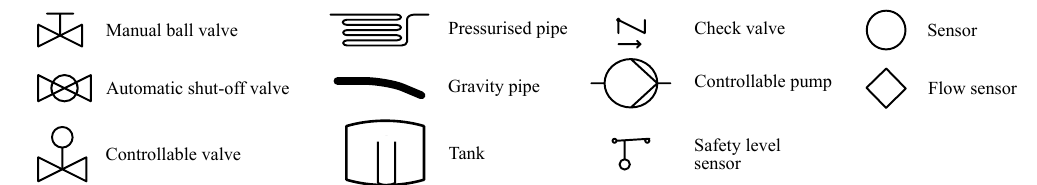
Figure A1. Legend of the piping and instrumentation diagrams.